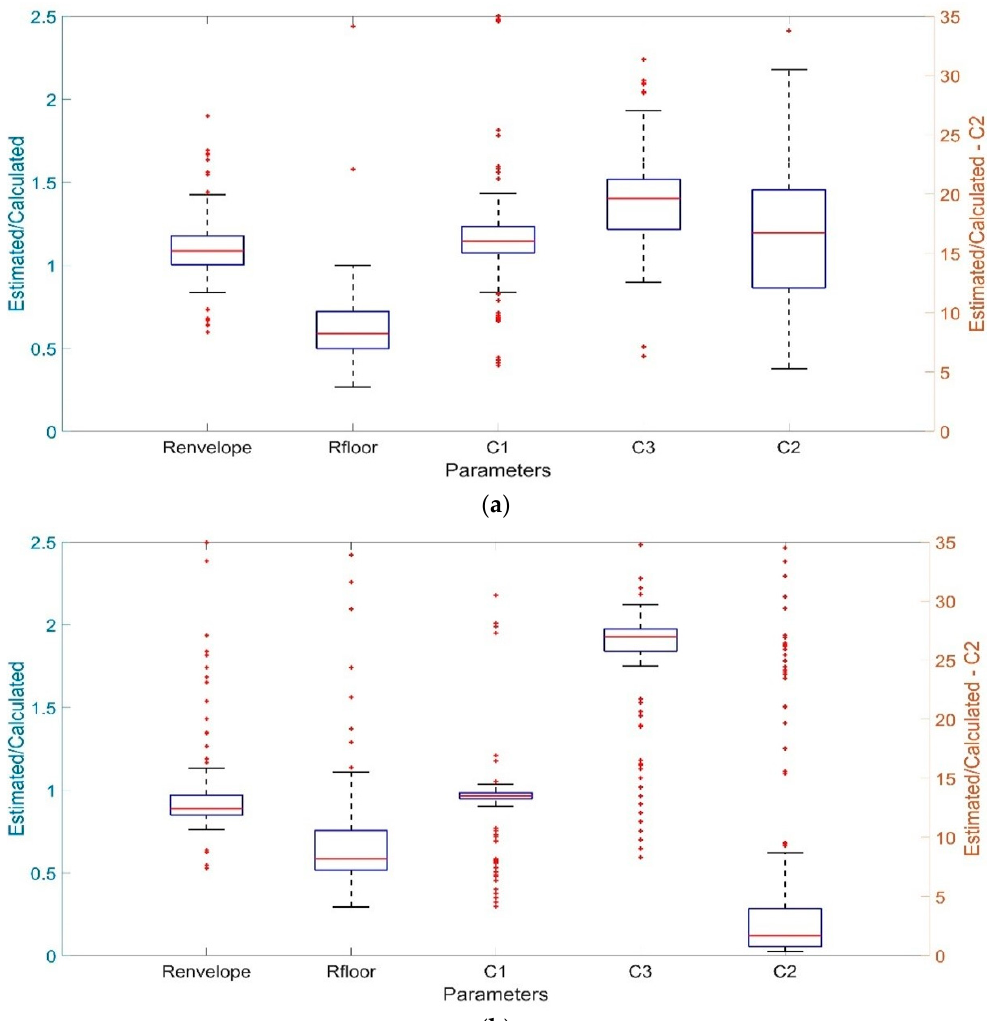
Figure 12. Variation of total thermal resistance and capacitances compared with their values from TRNSYS: ( a ) light- structured building; ( b ) heavy-structured building.